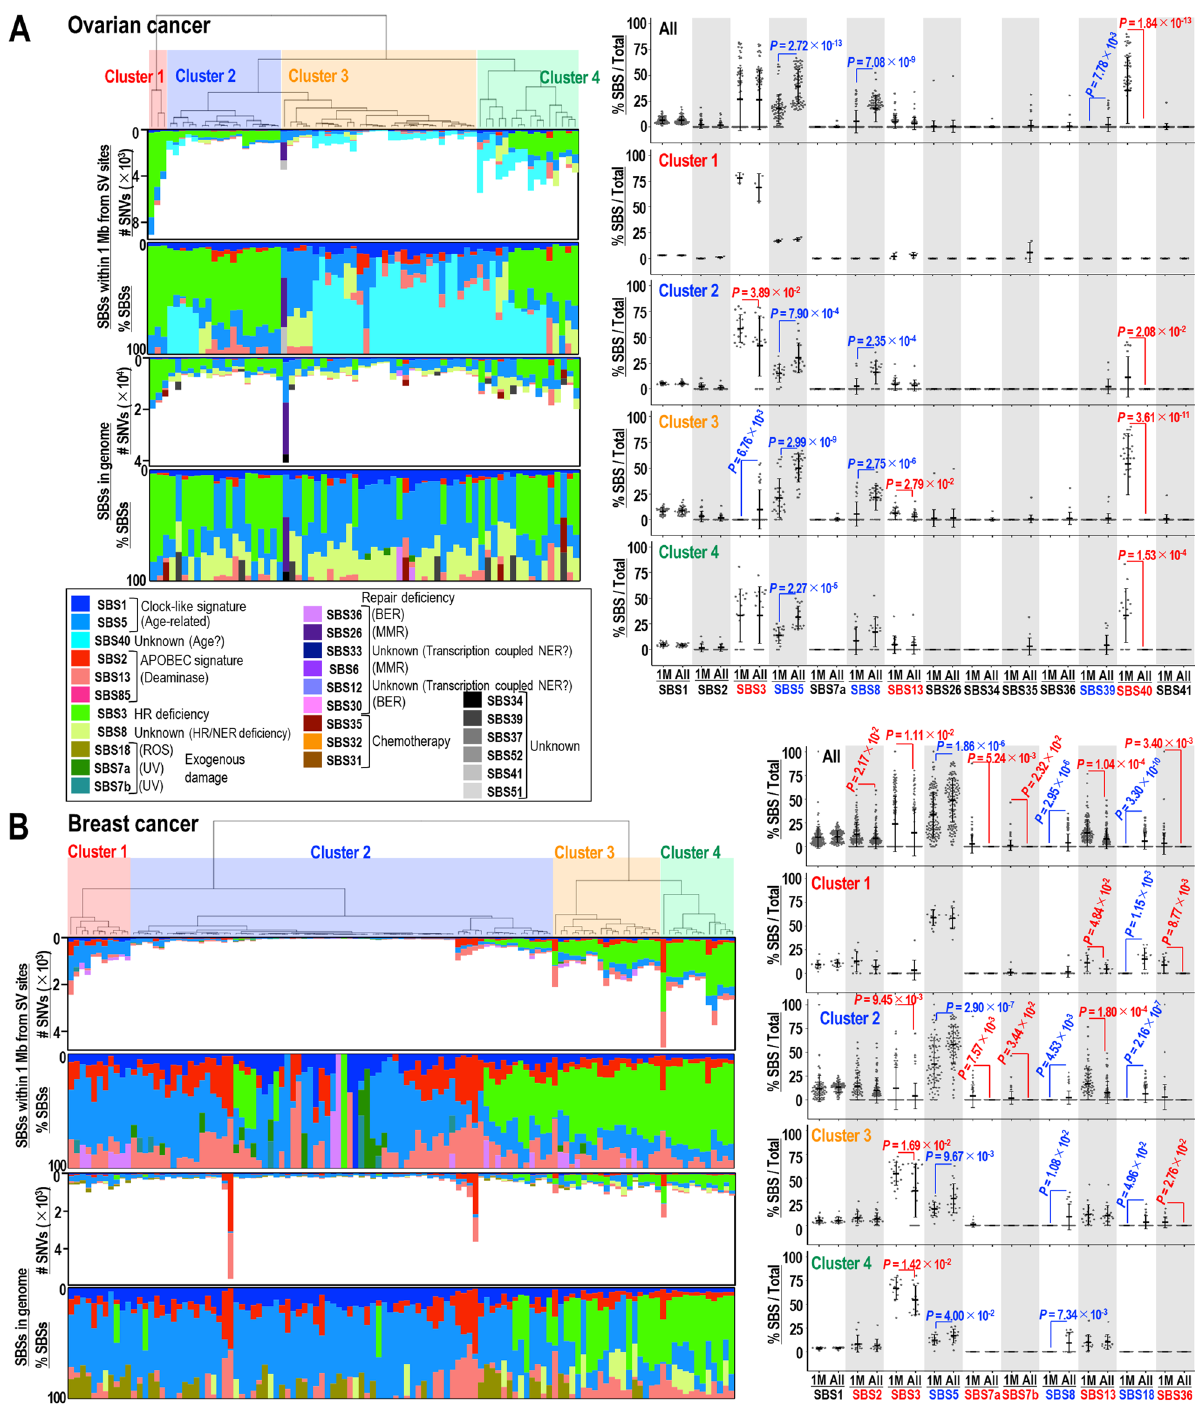
Figure 3. Biased inductions of APOBEC- and repair deficiency-associated signatures near SV sites in ovarian and breast cancers. ( A , B ) Signatures induced in ovarian ( A ) and breast ( B ) cancers within 1 Mb from SV sites (left upper panels) and in whole genomes (left bottom panels). The numbers of signatures were subsequently classified into four clusters. Percentages of SBS types induced in each tumor were plotted for all tumors and within each cluster (right panels). Statistical analyses by two-tailed Welch’s t